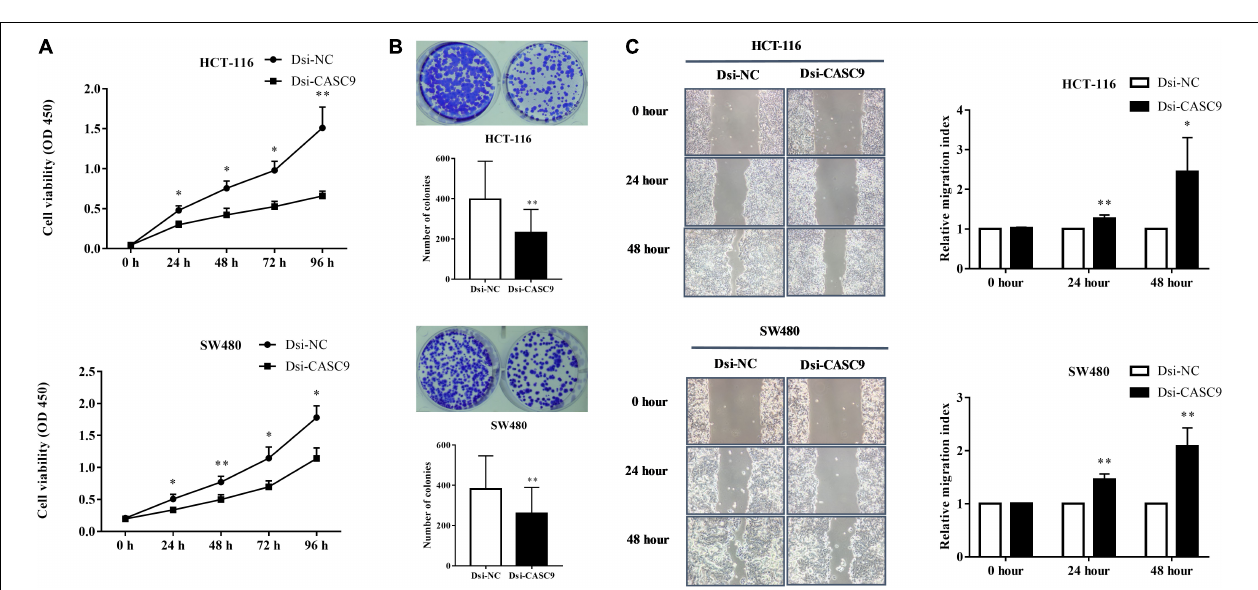
FIGURE 2 | CASC9 expressions in colon cell lines and effective silencing by Dicer-substrate siRNA. (A) The expression of CASC9 in CRC cell lines DLD-1, HT-29, SW480, and HCT-116 was compared with normal colon cell line CCD-112CoN using RT-qPCR. The data are shown as mean ± SEM of eight independent experiments. (B,C) Effective and consistent silencing of CASC9 by Dicer-substrate siRNA techniques was observed. The data are shown as mean ± SEM compared to the negative control Dsi-NC. n = 6, *** P < 0.001.